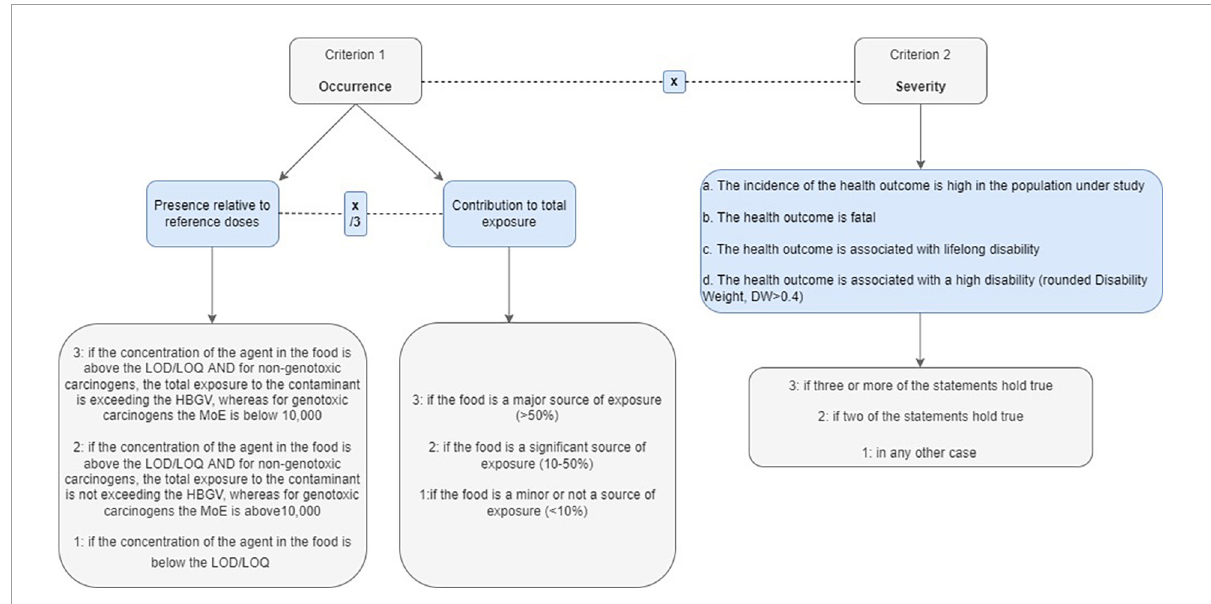
FIGURE6 Definition of sub-criteria of occurrence and severity considered in